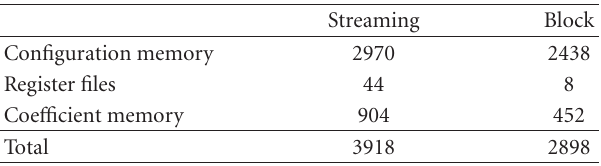
Table 7: Comparison of required clock cycles between streaming mode and block